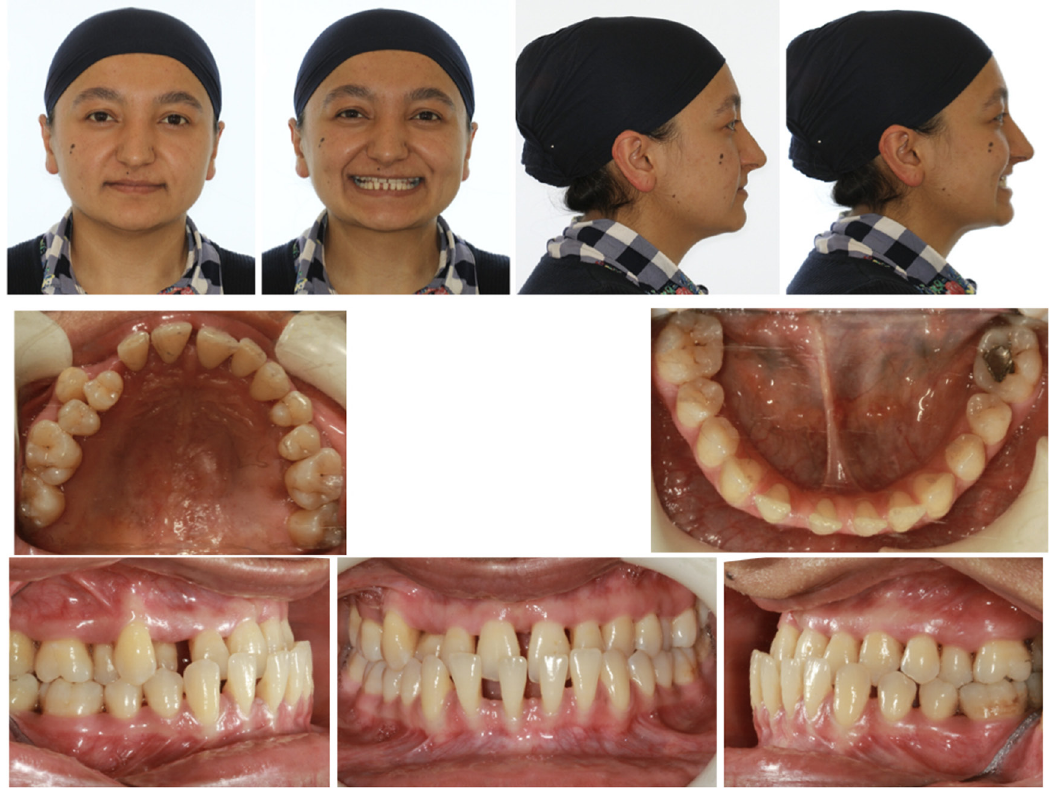
Figure 2. Pretreatment extraoral and intraoral